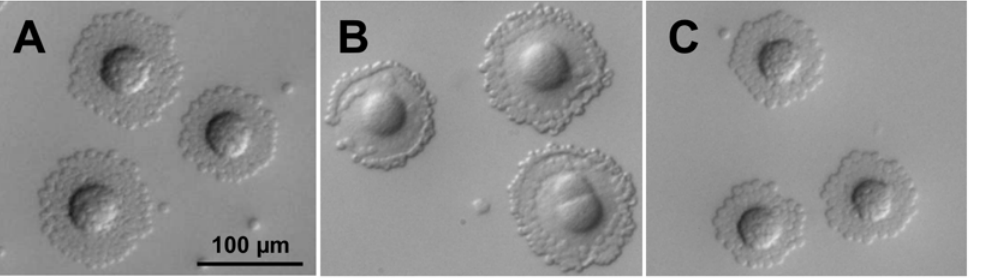
Figure 3. Hemadsorption activity analysis. Qualitative hemadsorption assay of the WT strain (A), the T192 mutant (B) and the T192C mutant (C). Colonies of the WT strain and the T192C mutant are fully covered by erythrocytes. In contrast, only the periphery of the T192 mutant colonies has erythrocytes bound.